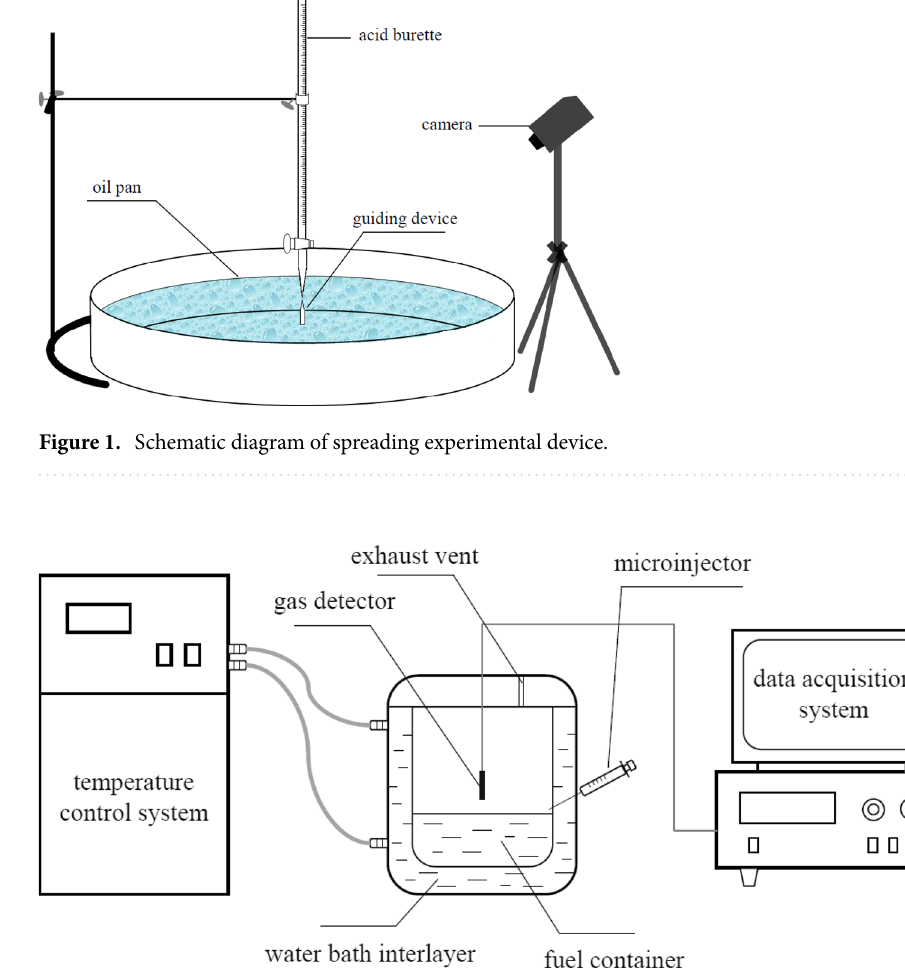
Figure 2. Schematic diagram of sealing experimental